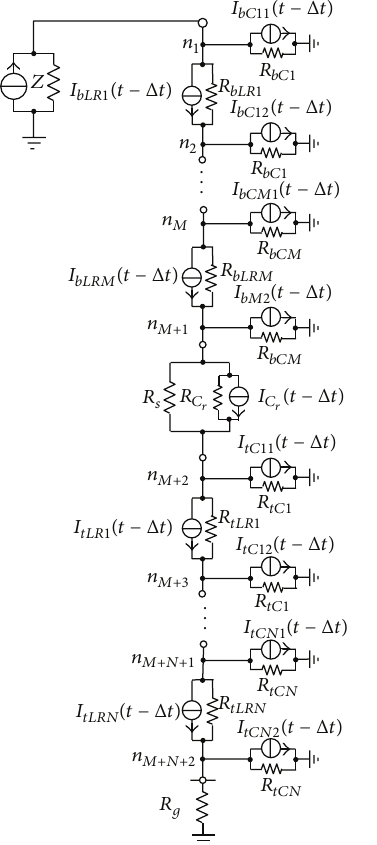
Figure 9: Time discretization circuit.